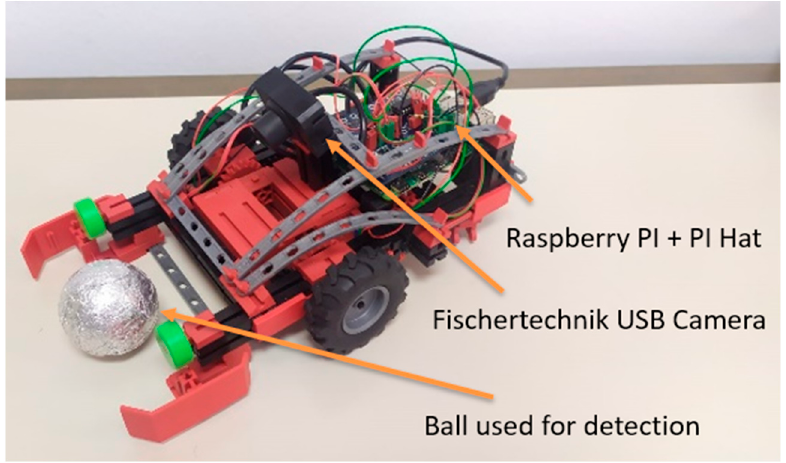
Figure 5. Educational robot with Raspberry Pi 4 Model B used for detection and localization of alu- minum balls. aluminum